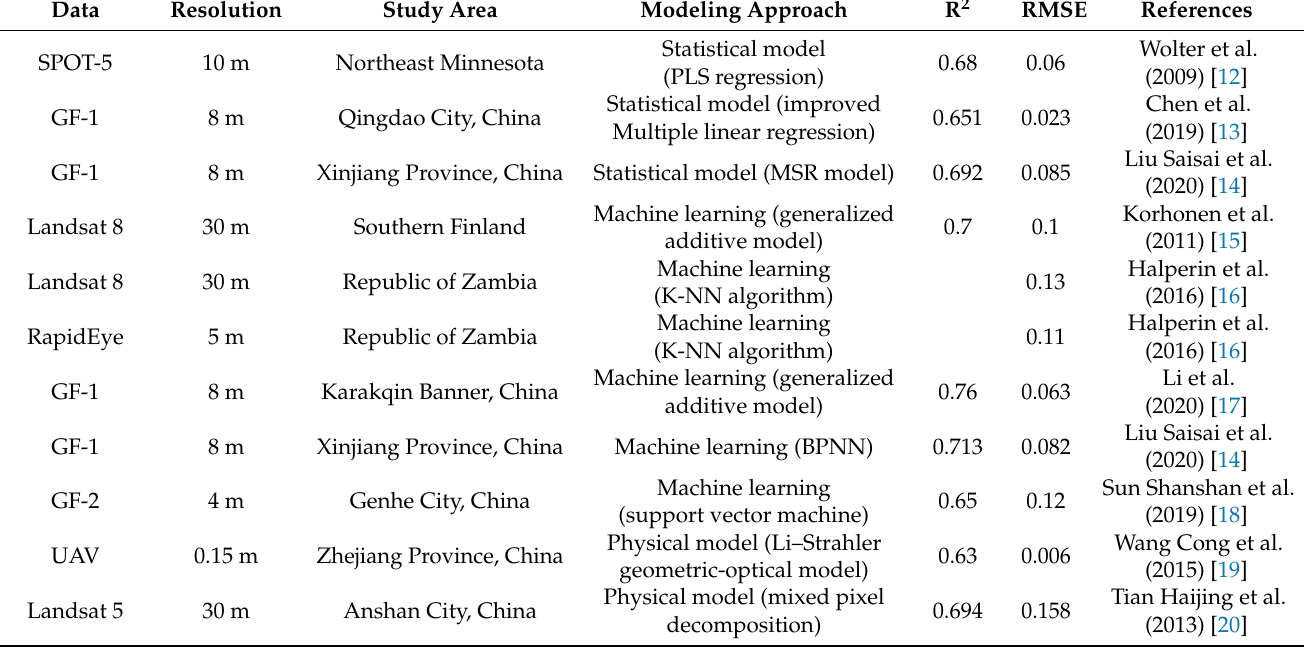
Table 1. Accuracy of CC estimation models for different multi-spectral remote sensing data sources.